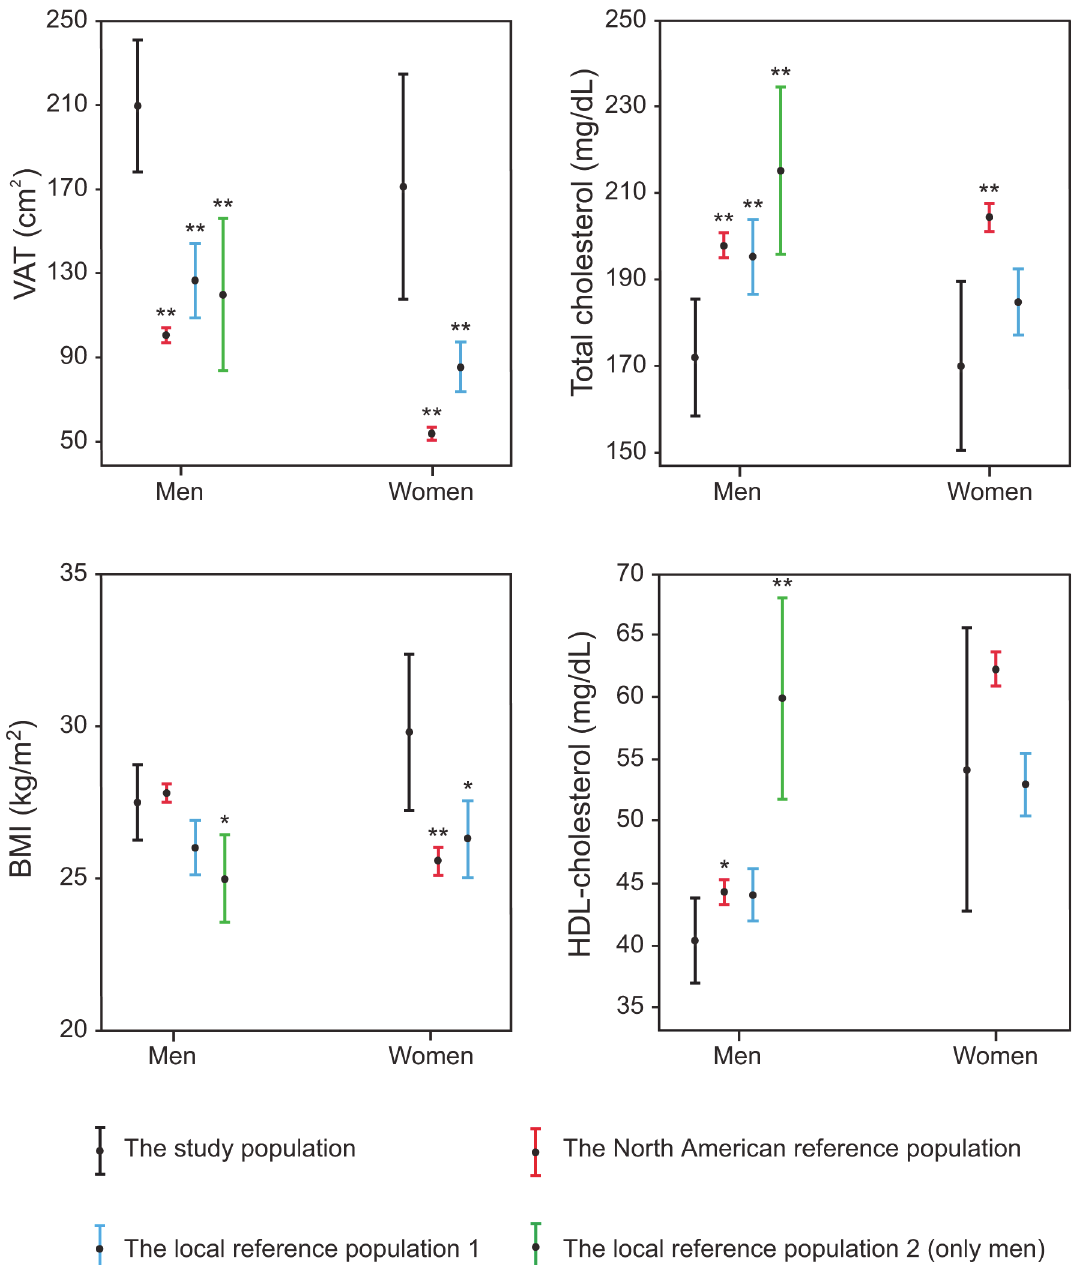
and 71% of female patients with overweight BMI (25 kg/m 2 (cid:1) BMI < 30 kg/m 2 ) had normal VAT area. Patient examples of normal and increased VAT are presented in Fig. 4. There were moderate positive correlations between VAT and BMI (r = 0.562, p < 0.001) and VAT and BSA (r = 0.453, p < 0.001). The number of patients with diabetes was small (n = 6) but this group of patients had larger VAT areas when compared to non-diabetics (319 cm 2 vs.